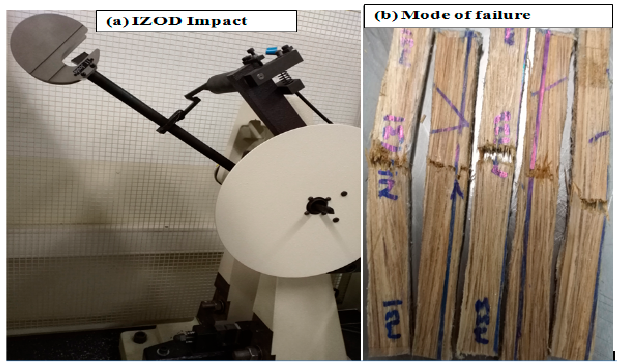
Figure 8. ( a ) Set up of Izod impact test, ( b ) mode of